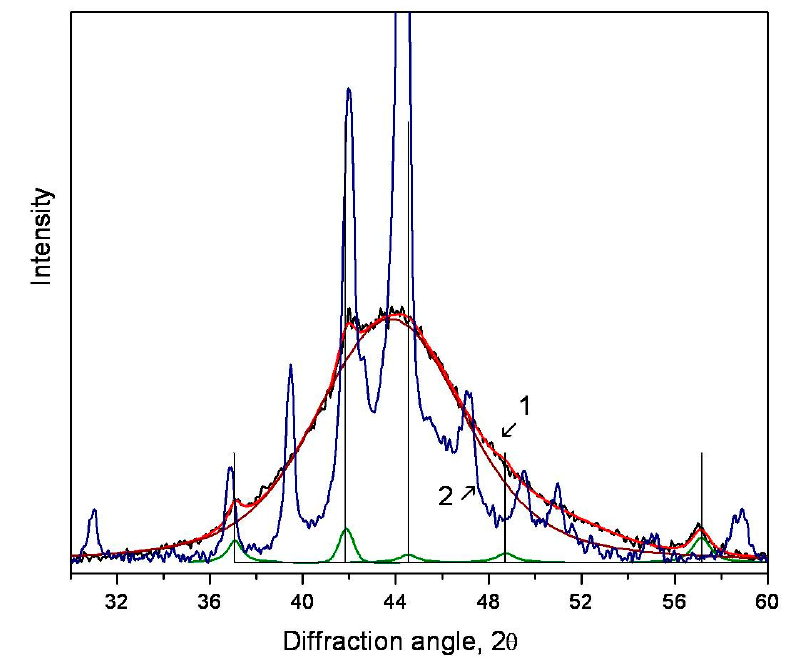
Figure 8. X-ray di ff raction patterns of the samples after high-pressure torsion (HPT) (1) and heating in the calorimeter (2, wine) to the temperature corresponding to the completion of the first crystallization stage (Co K α ). Decomposition of curve 1: 1(black)–experimental spectrum, 2 (red)–summation curve, 3 (blue)–di ff use halo from the amorphous phase (reflections corresponding to the crystalline phase (green) are marked with asterisks).